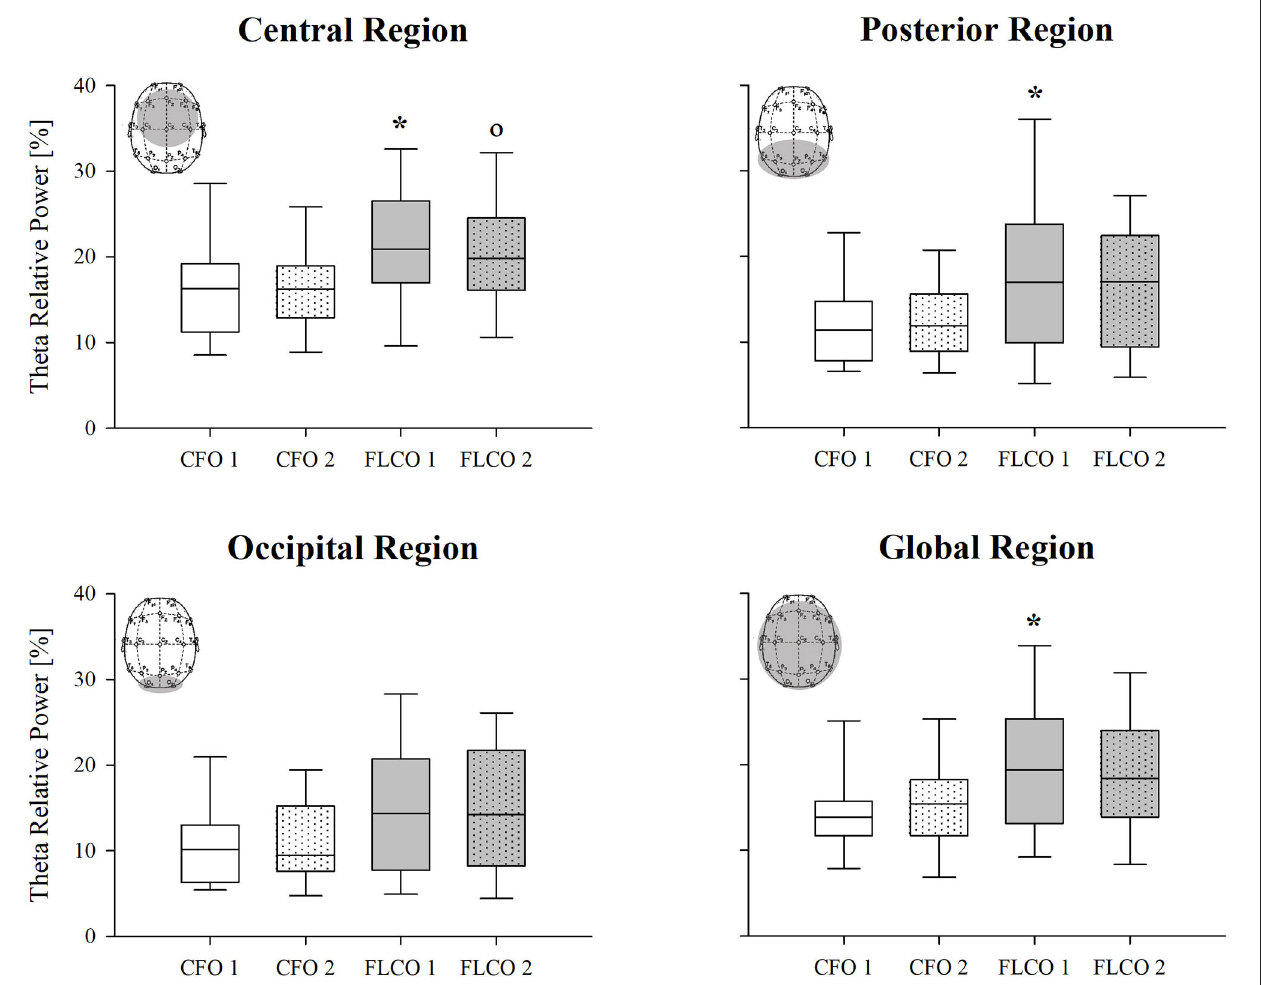
FIGURE 1 | A box-and-whisker plot representing the median (line within the box), the interquartile range (length of the box), the 90th and 10th percentiles (whiskers above and below the box) of the electroencephalographic derived theta relative power in central (top left panel), posterior (top right panel), occipital (bottom left panel), and global regions (bottom right panel) in operators who worked in COVID-19-free wards and departments (CFO, white) and in frontline COVID-19 operators during the pandemic (FLCO, gray) during the first (1) and the second sessions (2). * p < 0.05 CFO1 vs. FLCO1; ◦ p < 0.05 CFO2 vs. FLCO2.